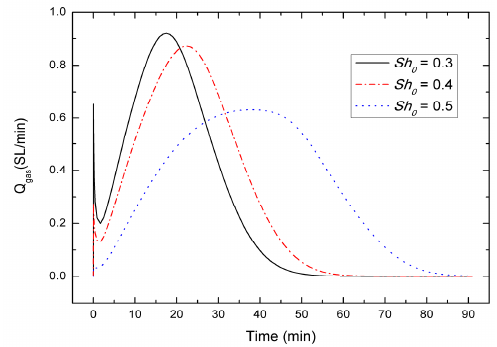
Figure 8. Gas generation rate with varying initial hydrate saturation.